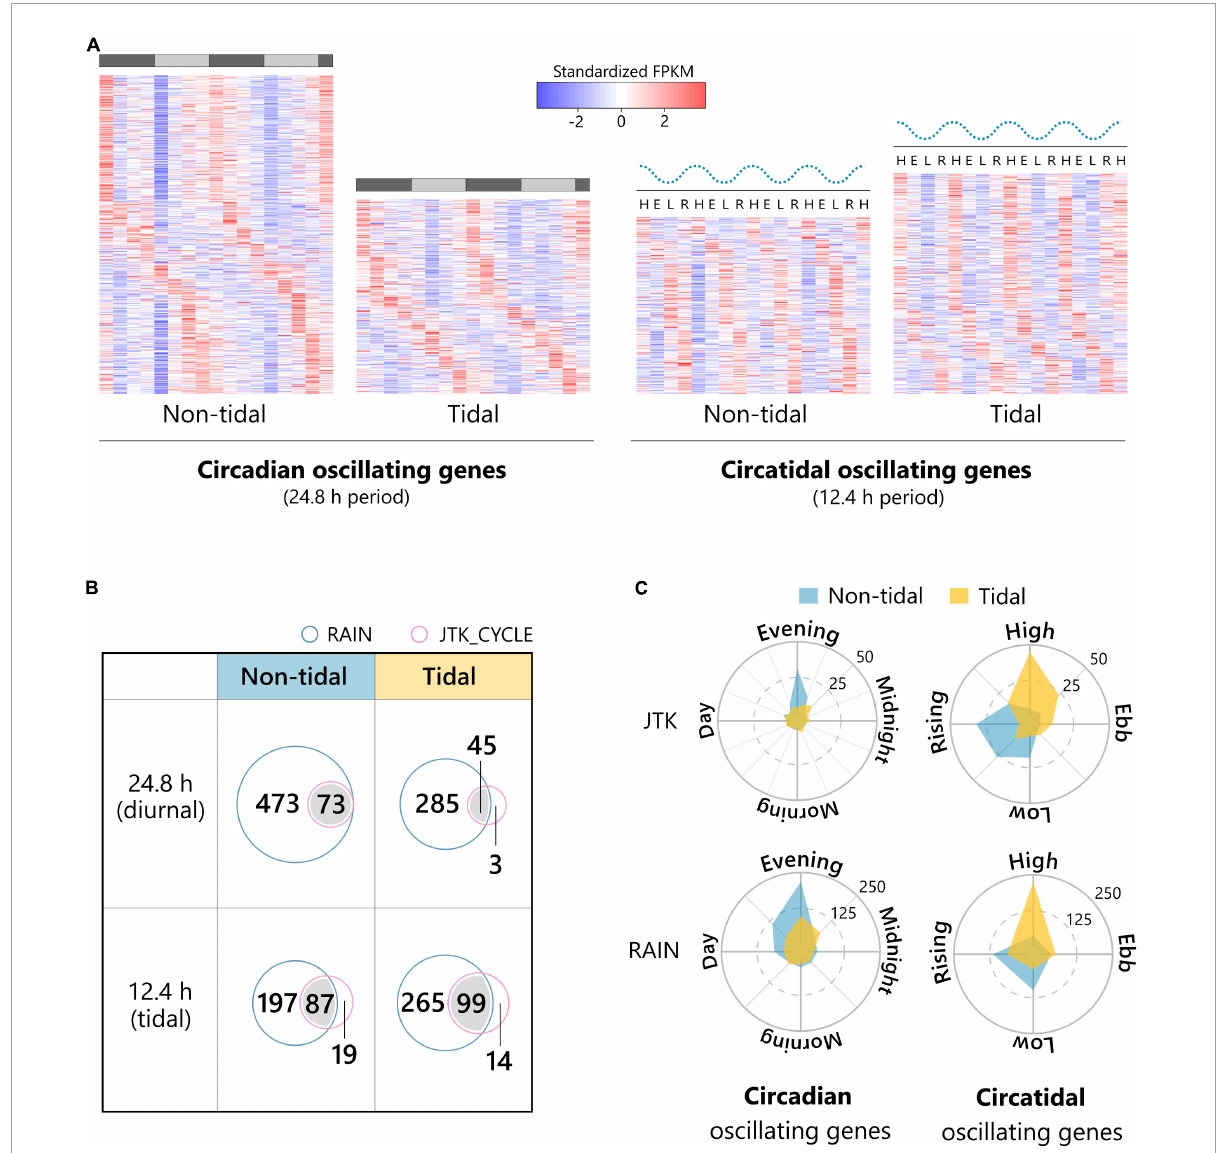
FIGURE2 Rhythmic transcripts with circadian and circatidal period in the non-tidal and tidal individuals. (A) Heatmaps of standardized expression patterns of rhythmic transcripts with 24.8 h (diurnal) or 12.4 h (tidal) period in the non-tidal and tidal individuals under DD conditions detected by JTK_CYCLE or RAIN. The dotted wavy lines above the heatmaps of tidal transcripts represent the tide level of the natural environment. H: subjective high tide, E: subjective ebb tide, L: subjective low tide, R: subjective rising tide. The gray and black bars above the heatmaps of diurnal transcripts represent the subjective day and night, respectively. (B) Venn diagrams detailing the number of rhythmic transcripts with 24.8 h (diurnal), or 12.4 h (tidal) period detected by JTK_CYCLE (pink circle) and/or RAIN (light blue circle). (C) The distribution of the phase of circadian and circatidal oscillating genes in the non-tidal and tidal individuals. Oscillating genes detected by both JTK_CYCLE and RAIN were included in both upper and bottom radar